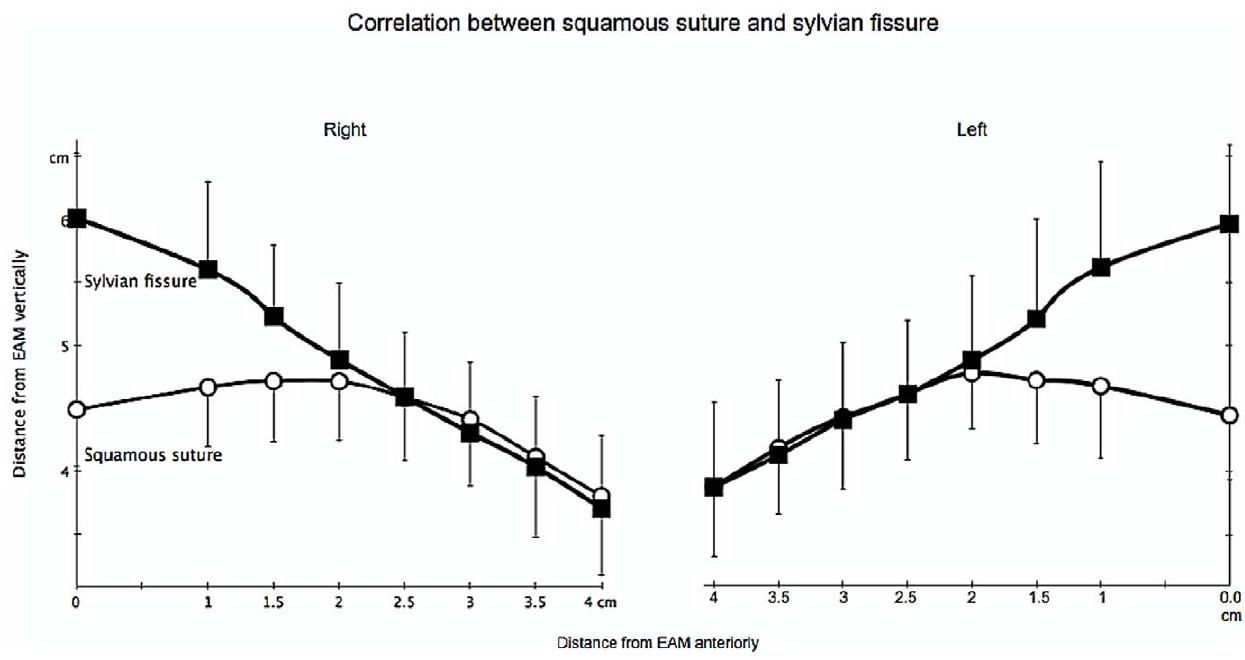
Figure 4. Correlation between Squamous suture and Sylvian fissure. doi:10.1371/journal.pone.0018199.g004 PLoS ONE |